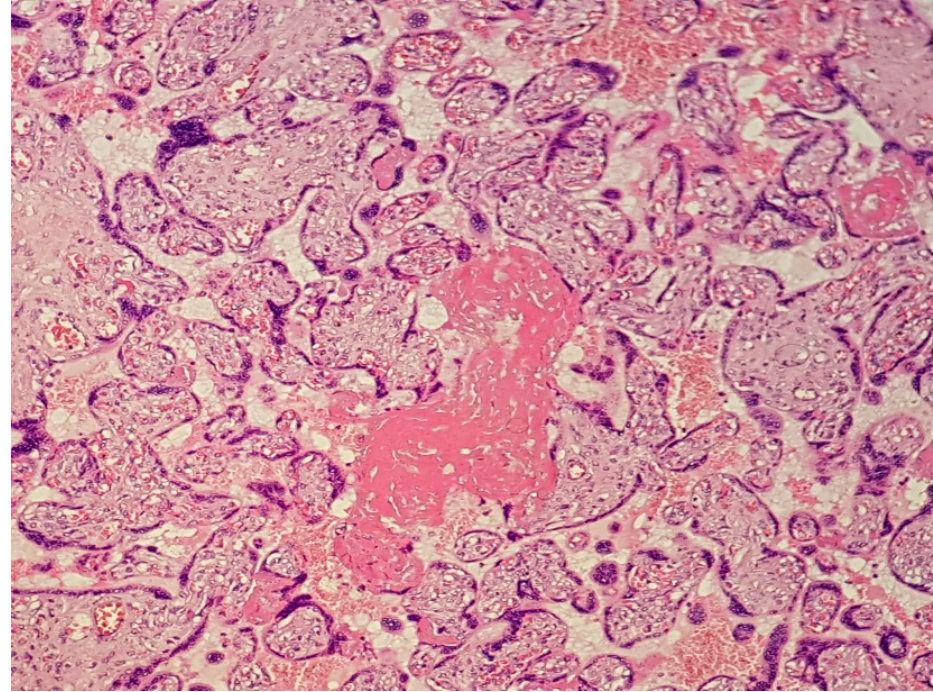
Figure 1. (Haematoxylin–eosin 10×). Presence of perivillous and intervillous fibrin with confluent aspects.